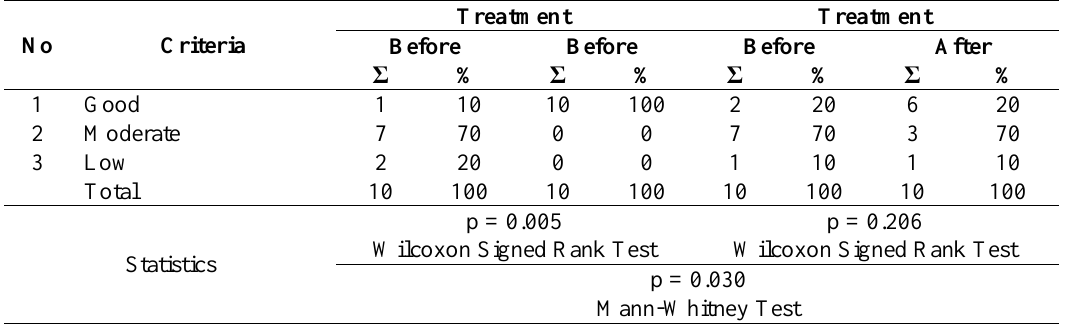
Table 1 Self-care ability level before and after given modeling participant treatment in control and treatment group at Dr. Radjiman Wediodiningrat Mental Hospital